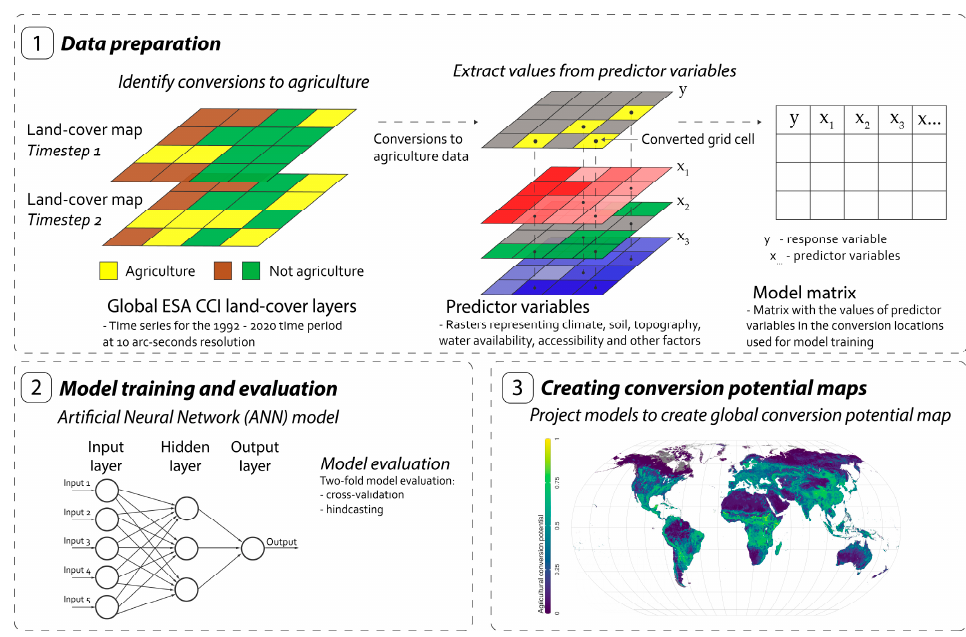
Figure 1. Schematic overview of the agricultural conversion potential modelling procedure according to three main steps: ( 1 ) data preparation: identification of locations of conversions to agriculture and extraction of predictor variables, ( 2 ) training and evaluating the ANN models, and ( 3 ) applying the trained models to create global maps of agricultural conversion potential.